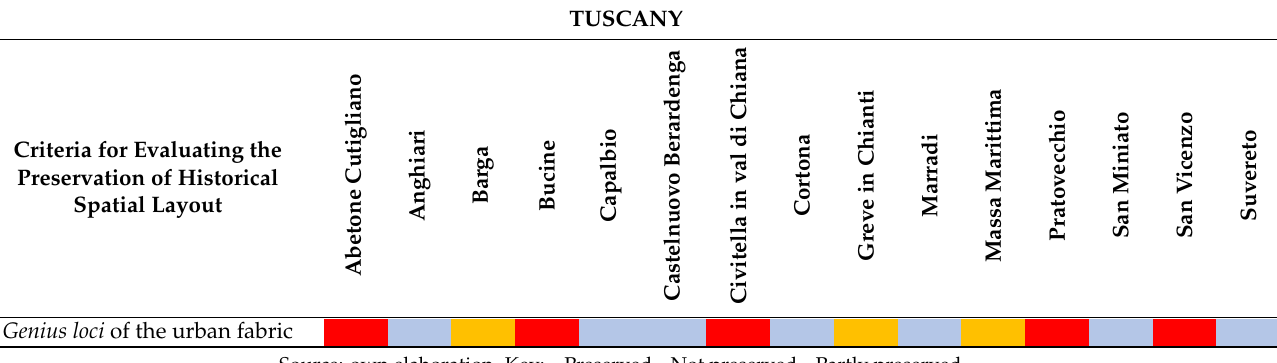
Table 16. Genius loci in Tuscan towns. TUSCANY